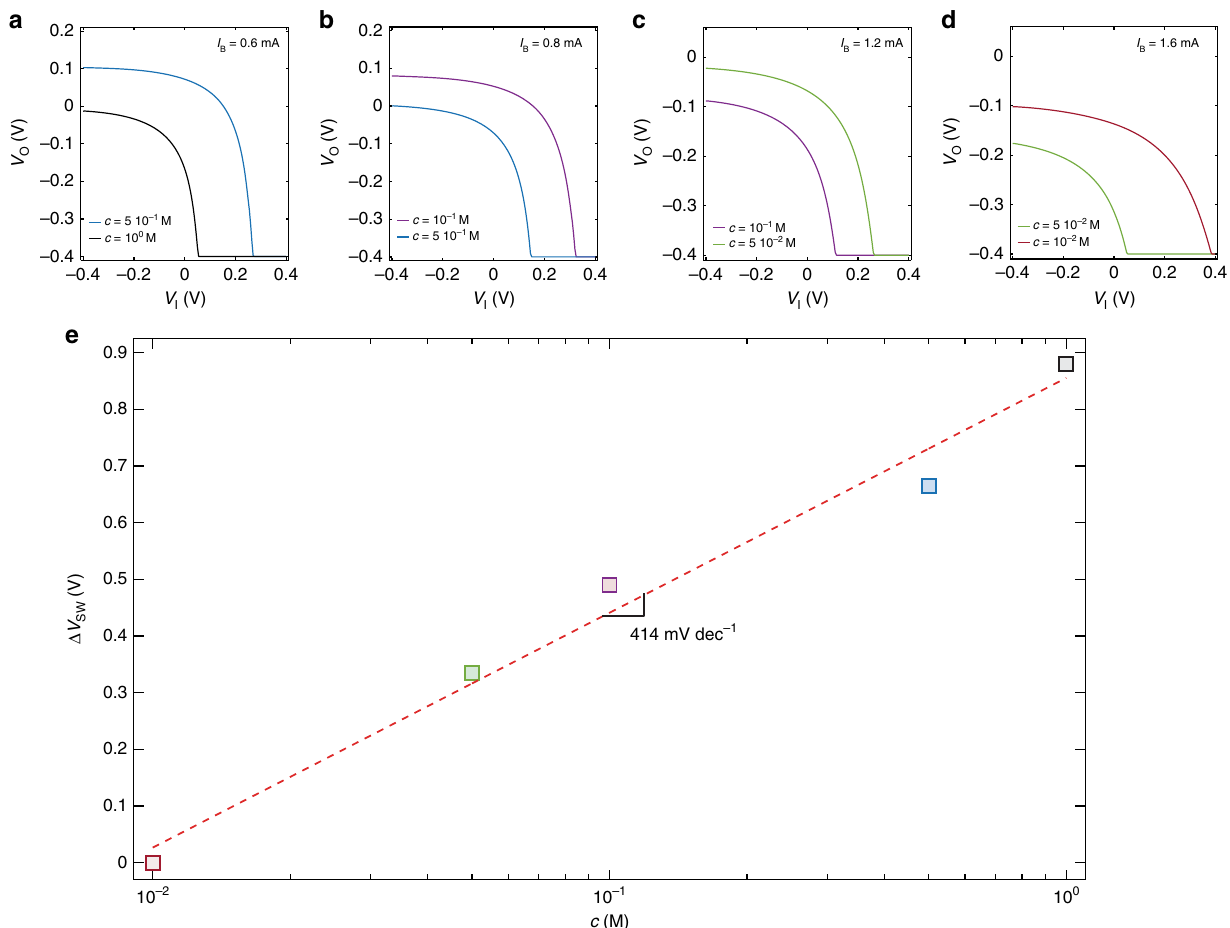
Fig. 6 Ion-selective current-driven OECT. a – d Measured transfer characteristics of an ion-selective current-driven OECT at several KCl concentrations c , V DD = 0.4 V. a I B = 0.6 mA, b I B = 0.8 mA, c I B = 1.2 mA, d I B = 1.6 mA. e Cumulative switching voltage variation Δ V SWi + 1 = Δ V SWi + ( V SWi + 1 − V SWi ) as a function of the ion concentration. The average sensitivity is 414 mV dec − 1 . The gate is a Ag/AgCl pellet, the membrane is selective to K + ions, and the OECTs geometries are: W = 1000 µ m, L = 300 µ m, t = 100